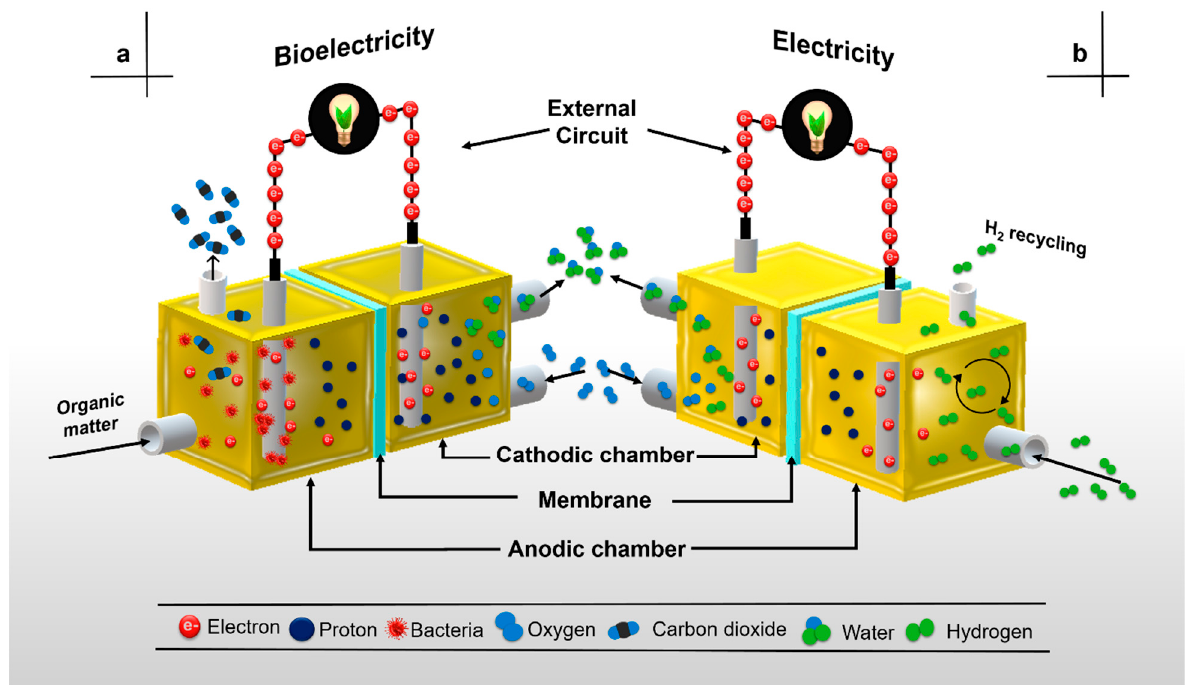
Figure 1. Basic components in ( a ) a microbial fuel cell and, ( b ) a fuel cell.